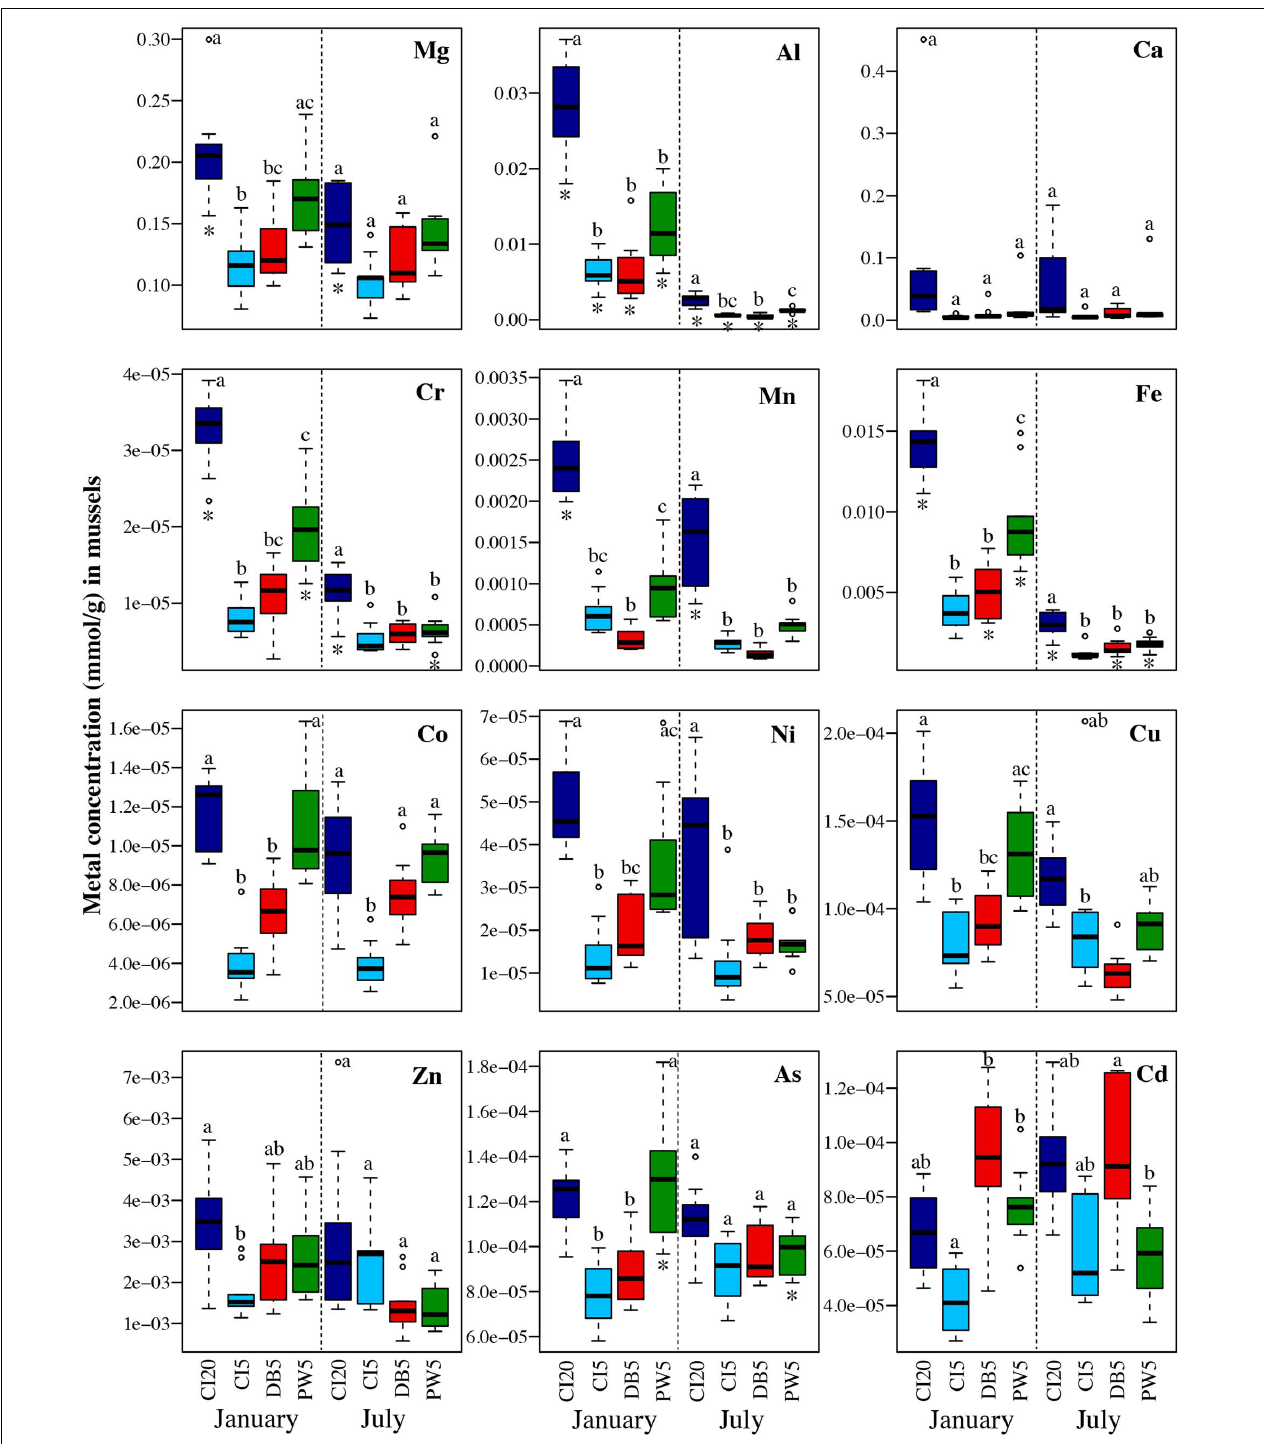
FIGURE 9 | Concentrations in mmol/g for each of the twelve analyzed trace metals in mussels held for 6 months (January) and 1 year (July) in four locations: Carr Inlet 20 m (dark blue), Carr Inlet 5 m (light blue), Dabob Bay 5 m (red), and Point Wells 5 m (green). ANOVAs and Tukey Post-Hoc Tests with a Bonferroni correction were used to see if there were significant differences (alpha of 0.004) between location for January and July separately , and differences are indicated by letter above each boxplot. Separate ANOVA and Tukey Post-Hoc Tests were also completed to compare across time periods. Asterisks below the box plot indicate a significant difference (alpha of 0.004) in the concentration of a metal at one site between January and July .